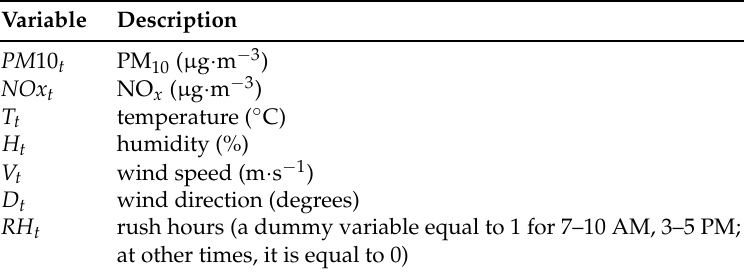
Table 1. Notation for the measured